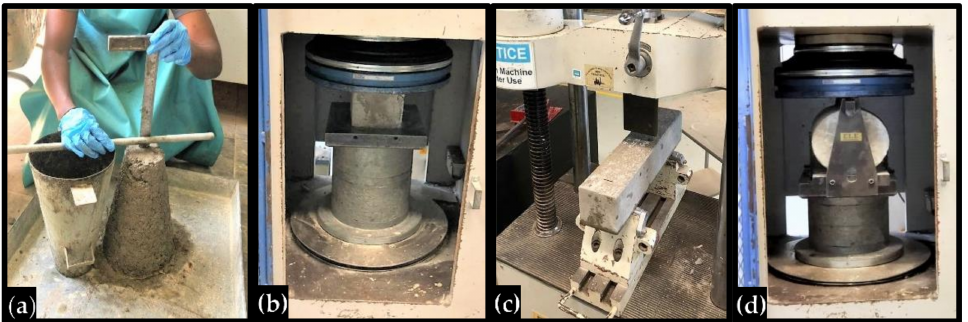
Figure 3. Tests on the HVFA–CRC: ( a ) slump test, ( b ) compressive strength test, ( c ) flexural test, and ( d ) splitting tensile